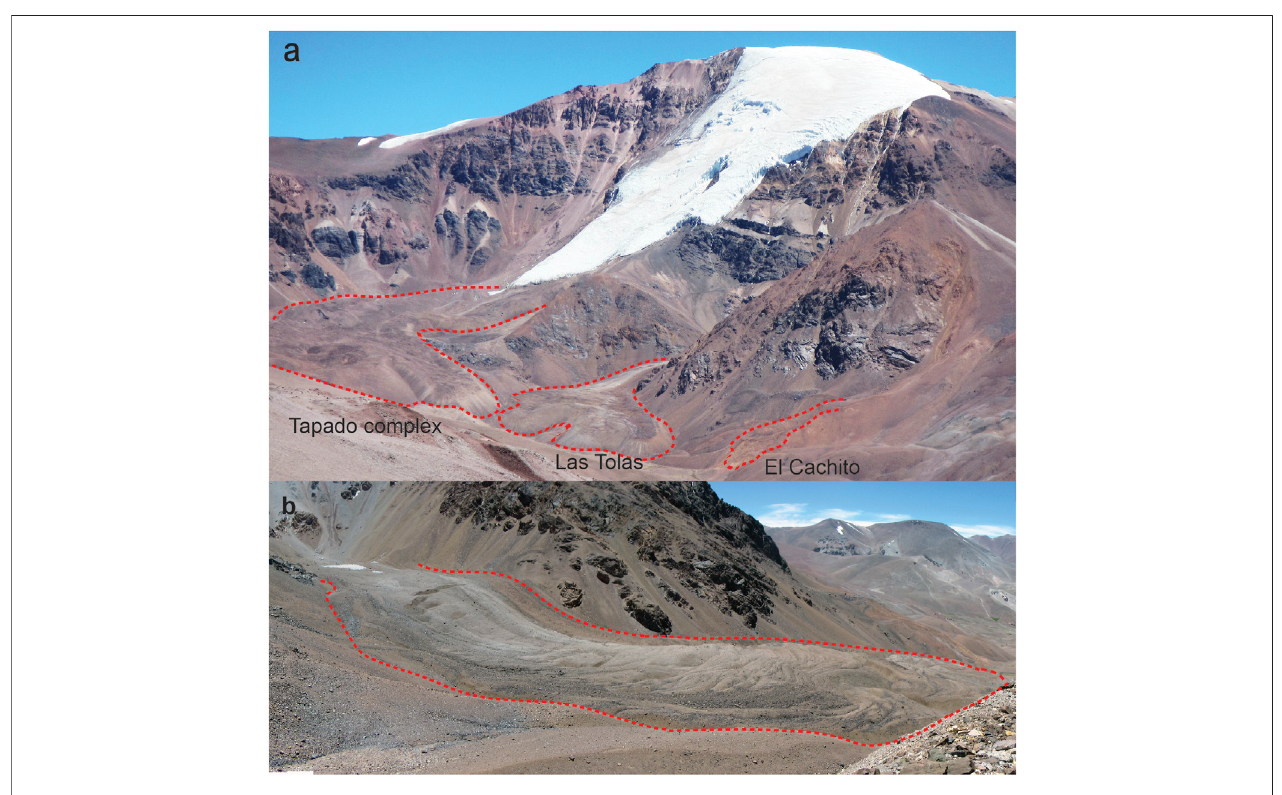
FIGURE 2 | Terrestrial view of the study area. (A) Overview of Tapado site with the three studied units (05.02.2015). (B) The tongue-shaped Las Tolas rock glacier with clear margins (also note the crevasses in the upper area) and well-developed furrows and ridges (01.02.2018).